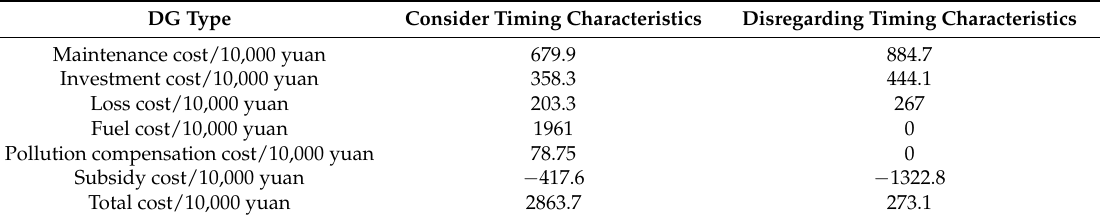
Table 4. Costs of planning